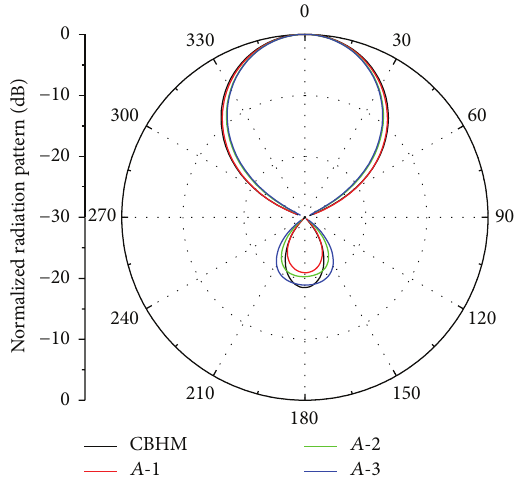
Figure 17: H -plane radiation patterns: side-by-side